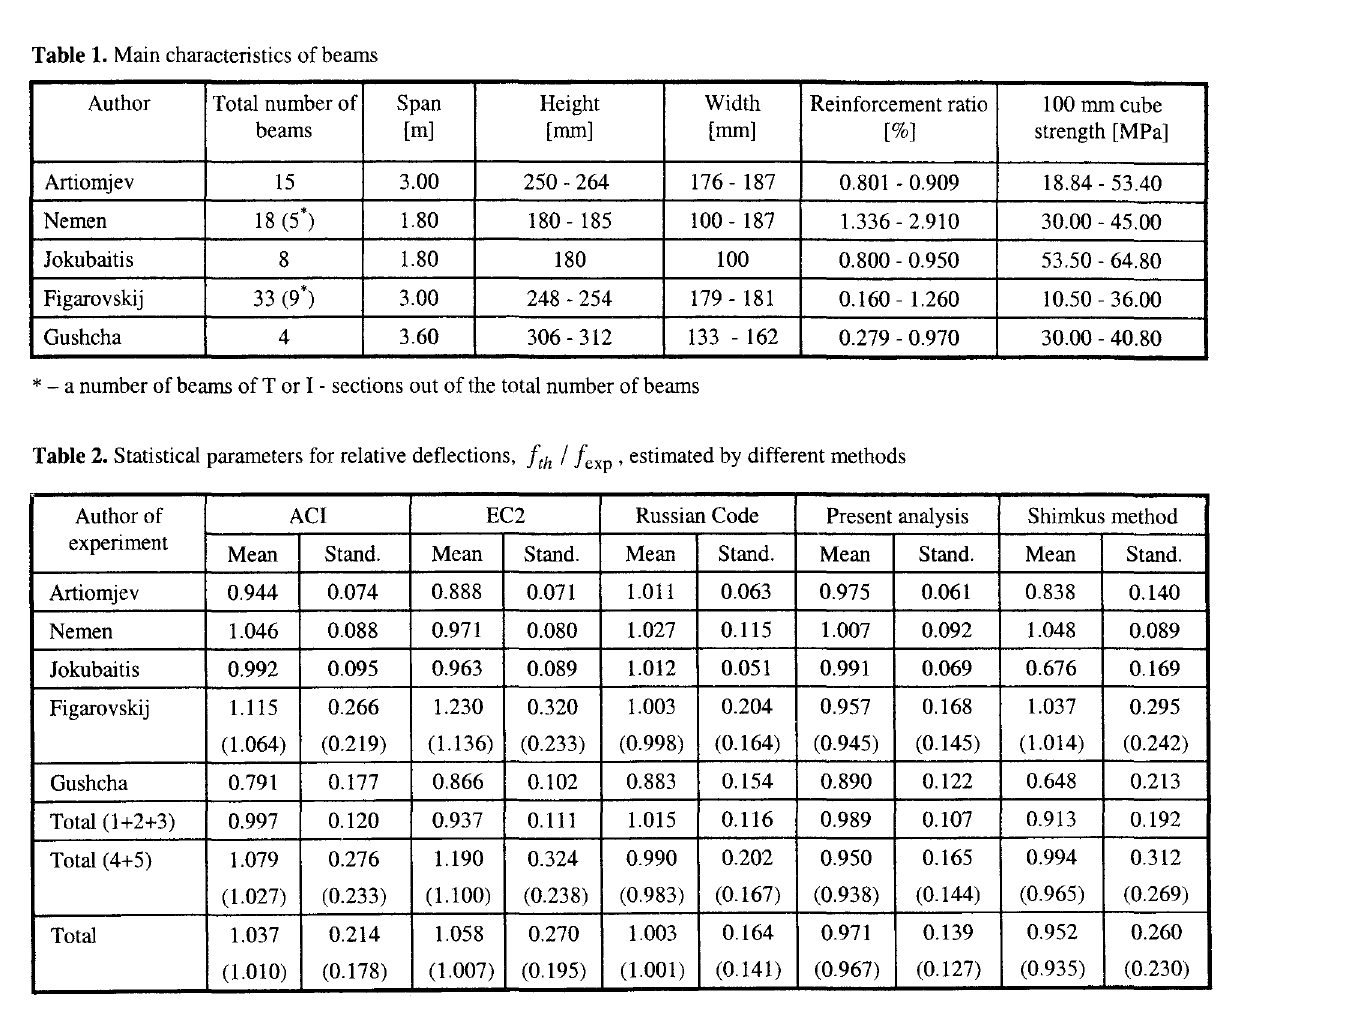
Table 2. Statistical parameters for relative deflections, fth I fcxp , estimated by different methods Author of ACI